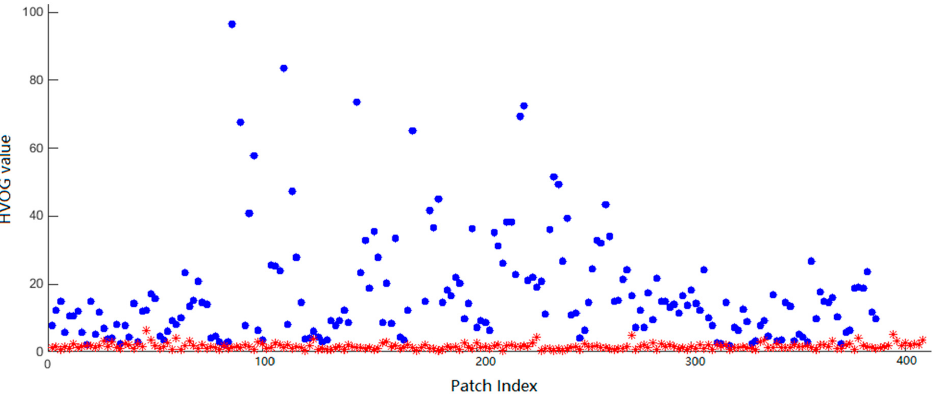
Figure 4. The obtained HVOG values (multiplied by 1000) of all patches. The HVOG values of the structure and flat patches are shown in blue and red, respectively.